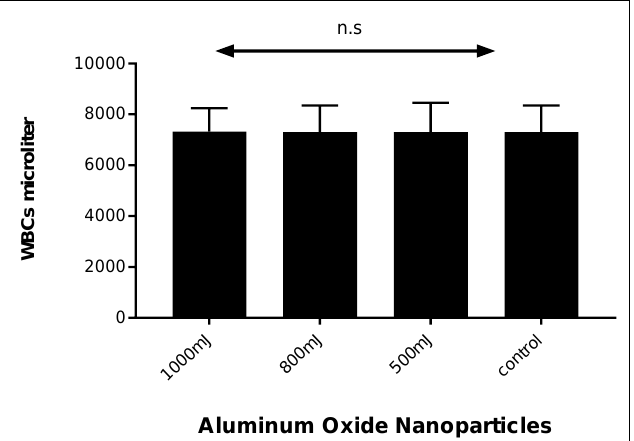
Figure 9: WBCs count in blood samples in the presence and absence of Al 2 O 3 NPS at different energy (500, 800, and 1000) mJ.